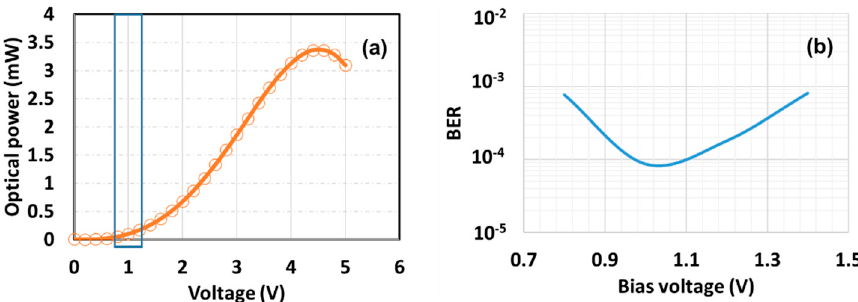
Figure 3. ( a ) The Mach–Zehnder intensity modulator (MZM) transfer function and the identified optimum modulation regime in the inset block and ( b ) bit-error-rate (BER) vs. modulator bias voltage for optical back to back case.